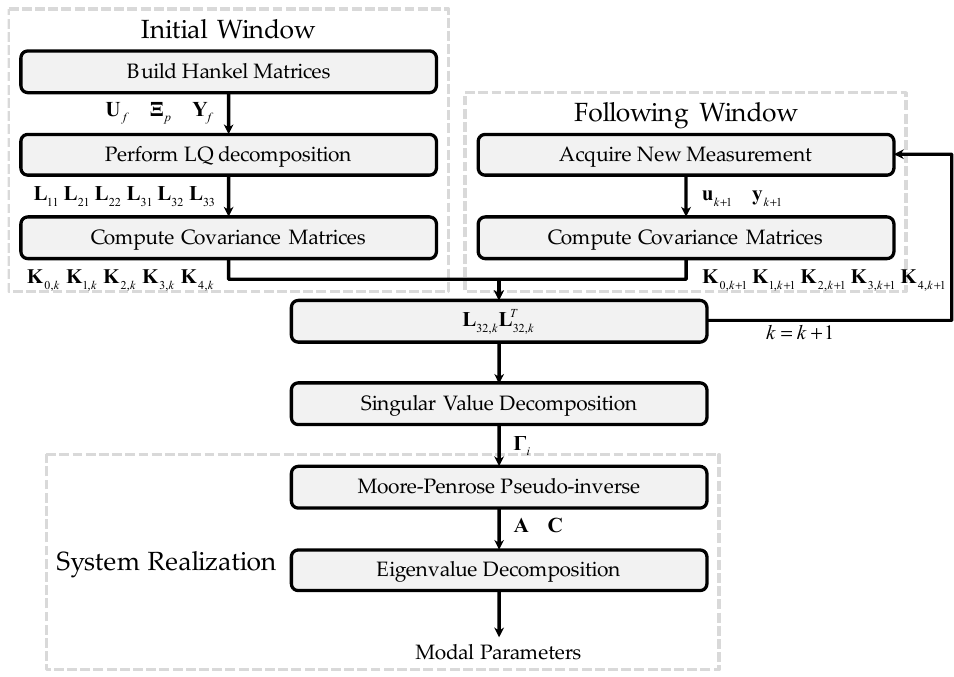
Figure 2. The flowchart for RSI implementation using bona fide recursive algorithm.